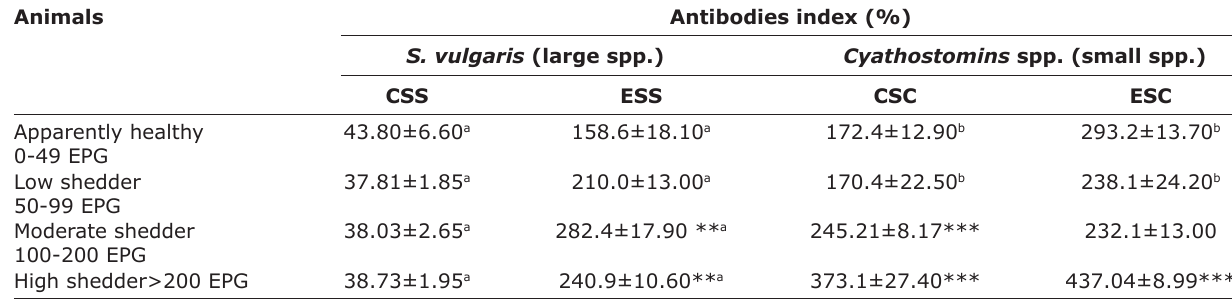
Table-3: Immunodiagnostic values of antibodies index for CS and ES of S. vulgaris and Cyathostomins spp. in donkey (%). Animals